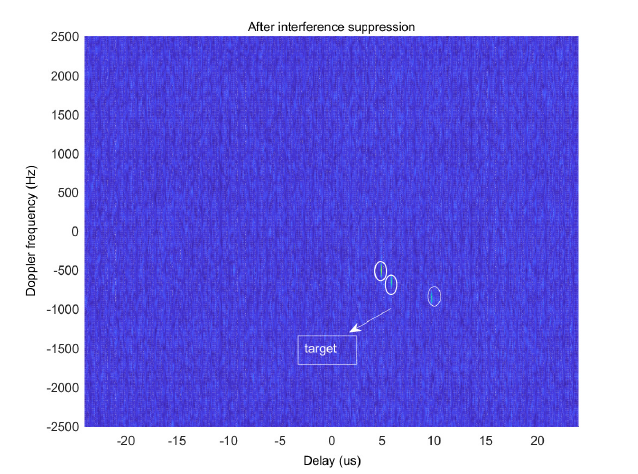
Figure 12. Time-frequency two-dimensional graph after direct wave multipath interference